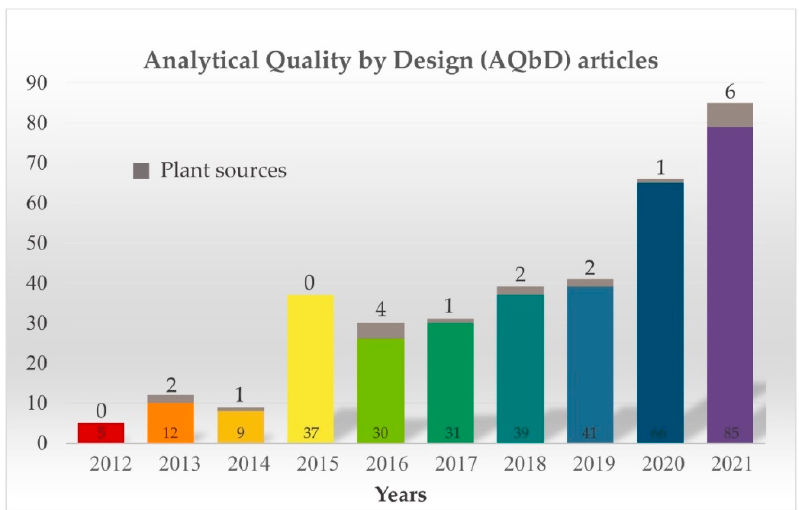
Figure 2. The number of scientific publications by year related to AQbD, searching “Analytical quality by design” (color bars) term in pharmaceutical industry, sorting papers for plant sources (gray bars), Scopus database (2012 to 2021).